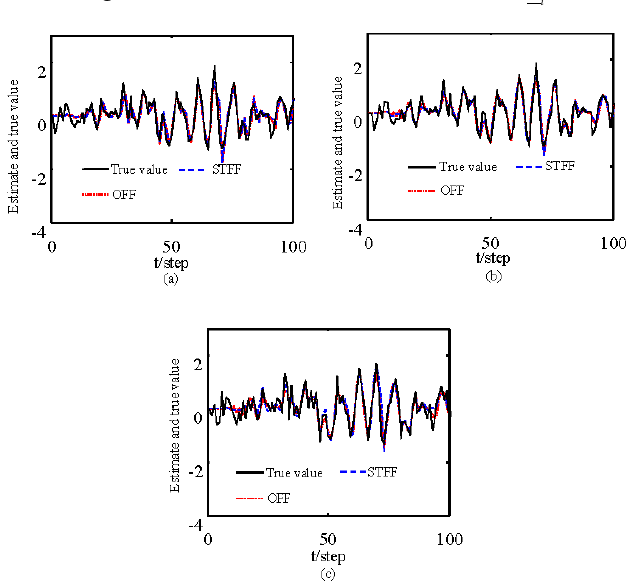
. Sensors 2019 , 19 , x FOR PEER REVIEW i